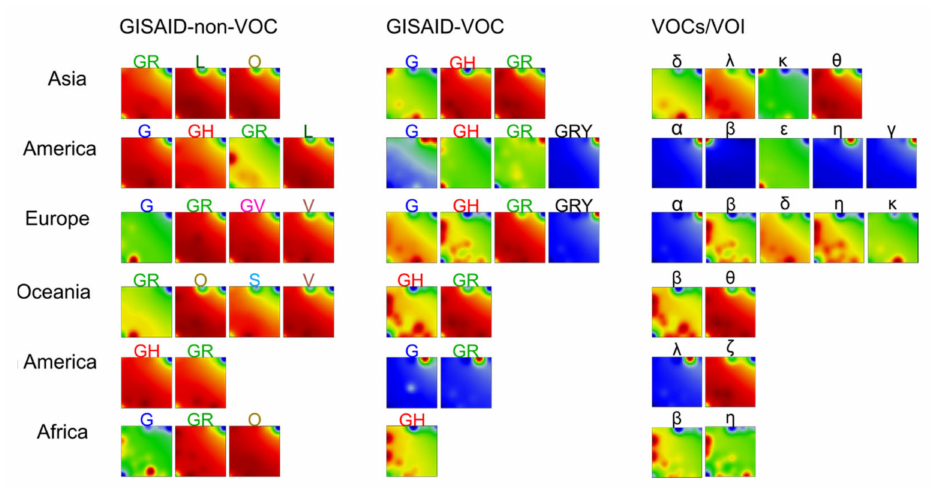
Figure A4. Portraits of the SARS-CoV-2 genomes from different regions of the world for GISAID non-VOC, VOC and WHO VOC/VOI groups. The patterns roughly agree with the overall worldwide portraits (Figure 2d). The portraits of the beta (‘South African’) variant slightly differ between Europe, Africa and North America because of unknown reasons. Lambda (South America) resembles the eta variant.